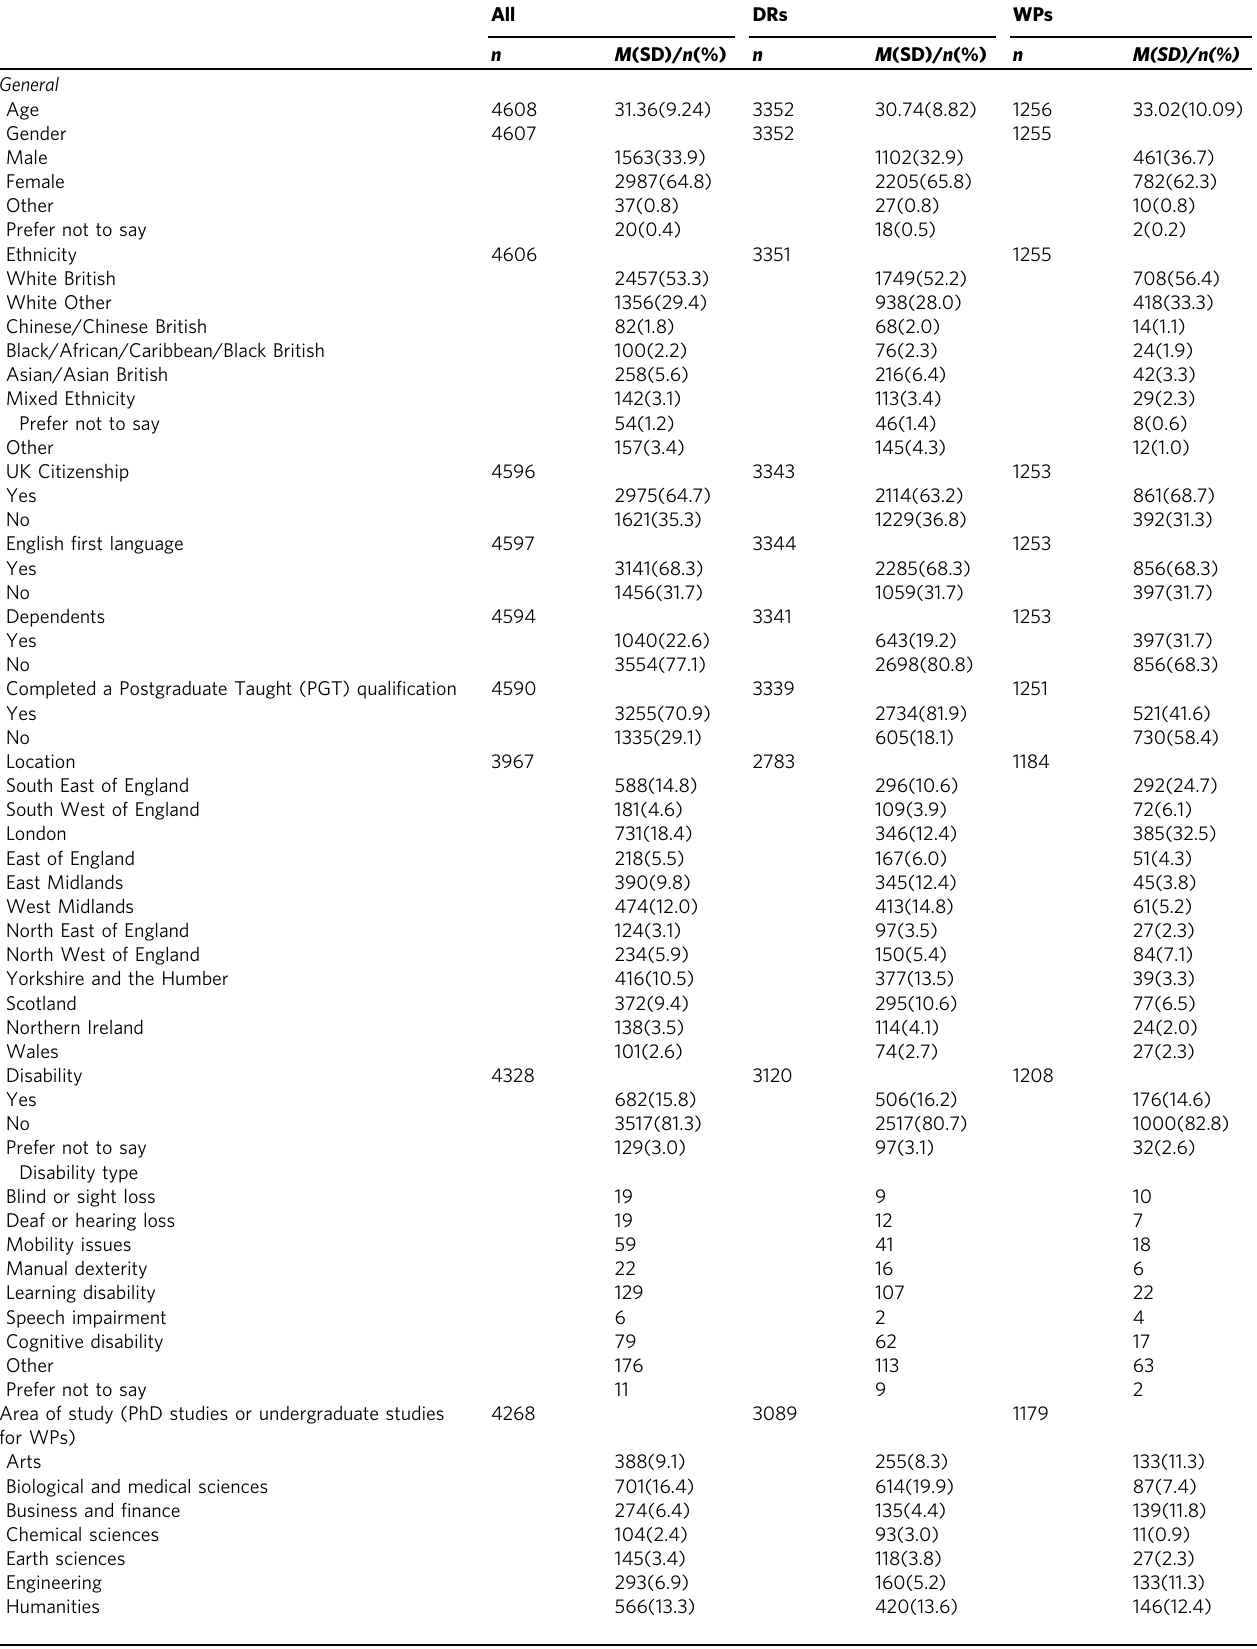
Table 1 Sample characteristics for the total sample and separated by DRs versus